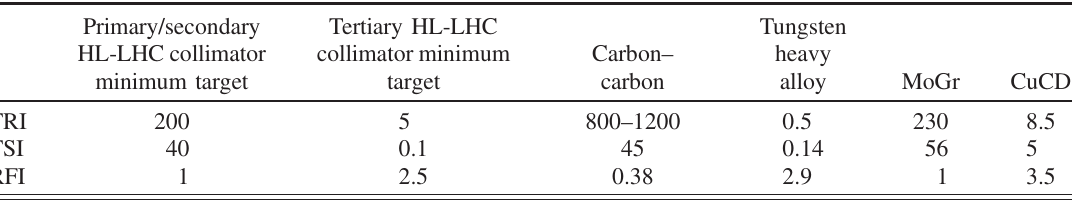
TABLE VI. Figures of merit for current materials adopted in LHC collimators (CFC and tungsten alloy), requirements for HL-LHC, and figures for the materials under investigation.